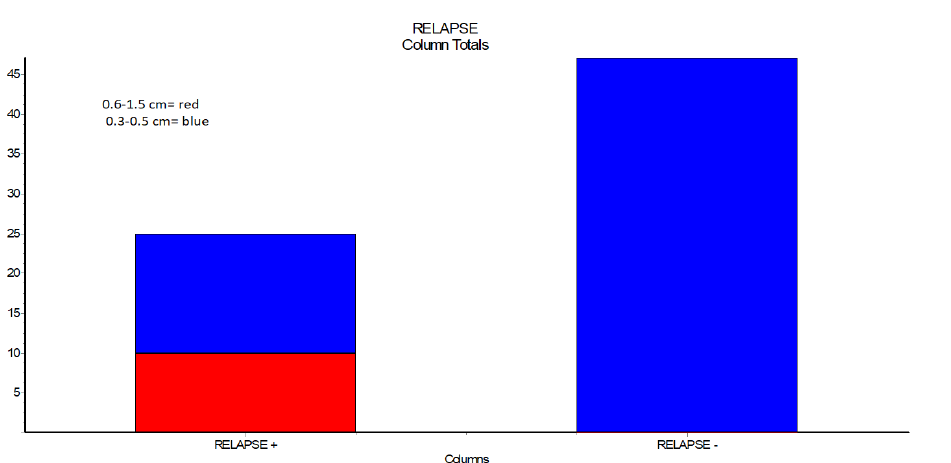
Figure 2. Relapses in case of closure with buccal advancement flap, the outcome for small defects and large defects.